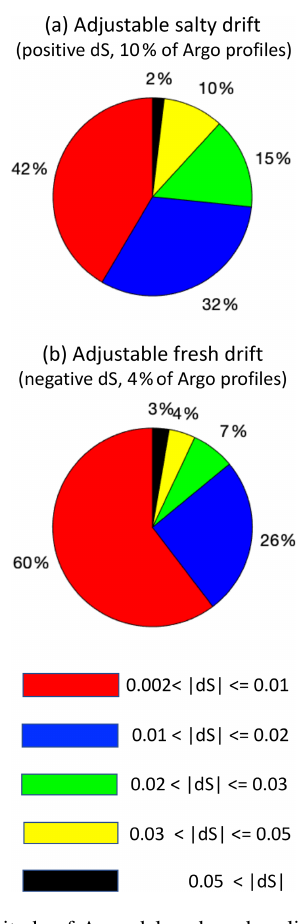
Figure 2. Magnitude of Argo delayed-mode salinity adjustments, as of April 2022. (a) Adjustable salty drift. (b) Adjustable fresh